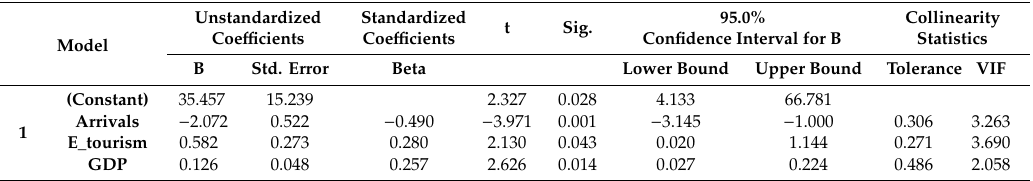
Table 6. Model coe ffi cients a .